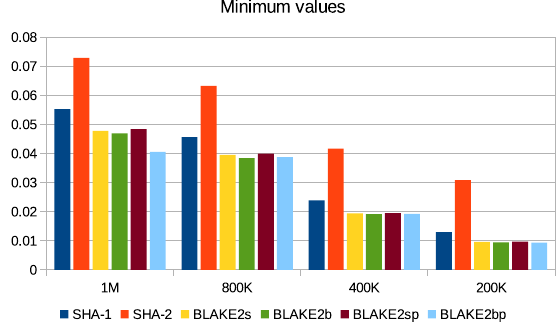
Figure 19. Minimum execution time of hash functions with different data